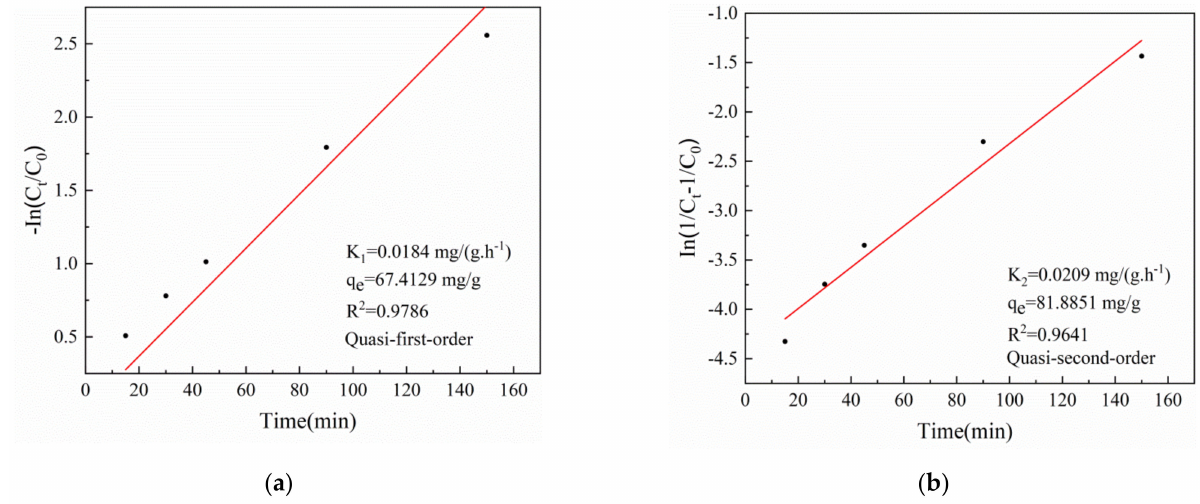
Figure 4. The model fitting results of ( a ) quasi first-order kinetics ( b ) quasi second-order kinetics.